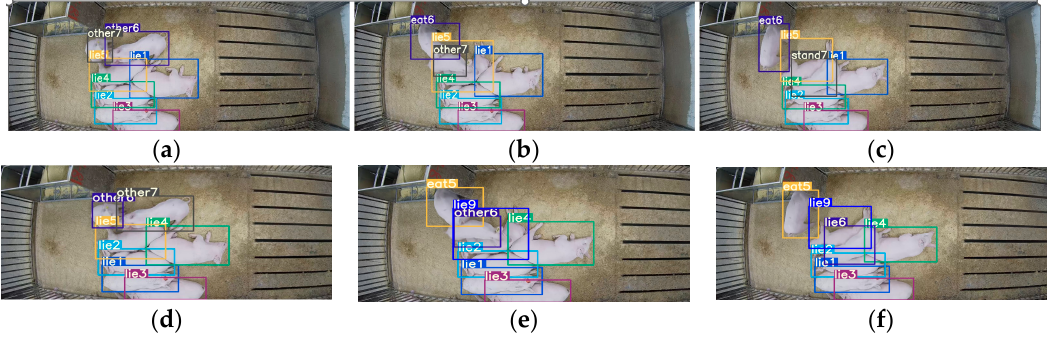
Figure 11. Tracking results for Pig02 using improved and original DeepSORT based on YOLOX-S model for day condition. ( a – c ) show the results of improved DeepSORT, and ( d – f ) show the results of original DeepSORT. ( a ) Improved model, frame 50; ( b ) Improved model, frame 100; ( c ) Improved model, frame 150; ( d ) original, frame 50; ( e ) original, frame 100; and ( f ) original, frame 150.